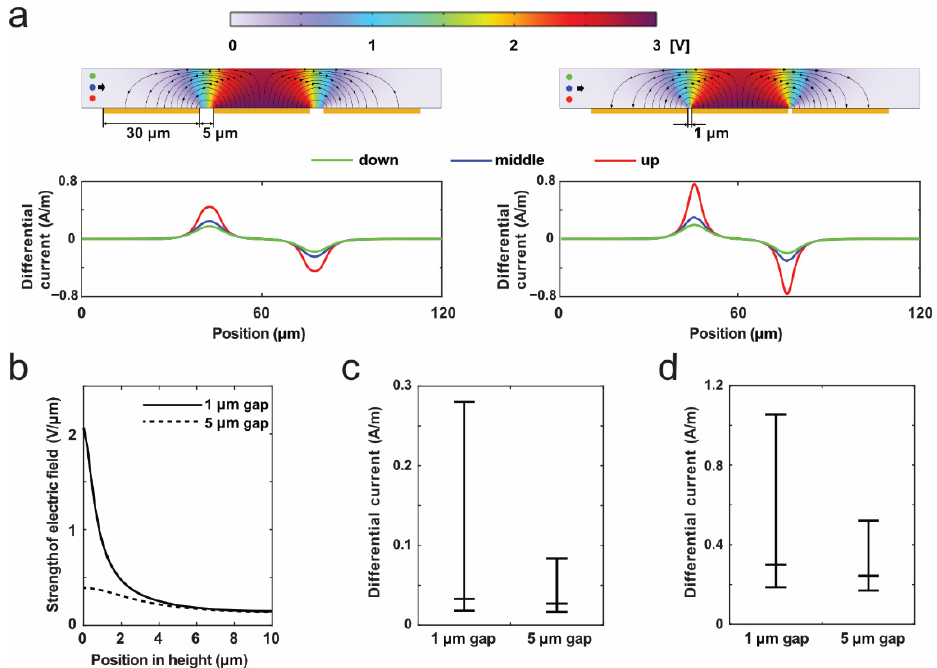
Figure 2. Simulation analysis of the impact of electrode span on the impedance detection. ( a ) Distri- bution of electric filed in the detection area of impedance cytometry (up), color represents the voltage, line with arrows means the current direction. The impedance pulses (down) were obtained when flowing 3 µm particle along three trajectories. The particles at different heights in the channel (i.e., 3 µm, 5 µm, 7 µm to channel bottom) were labelled in red, blue, and green, respectively. ( b ) Strength of electric field in the case of 1 µm gap and 5 µm gap. ( c , d ) Relationship between the impedance magnitude and the electrode gap, when measuring ( c ) 1 µm and ( d ) 3 µm particle. The impedance magnitude increases with decreasing the electrode gap.